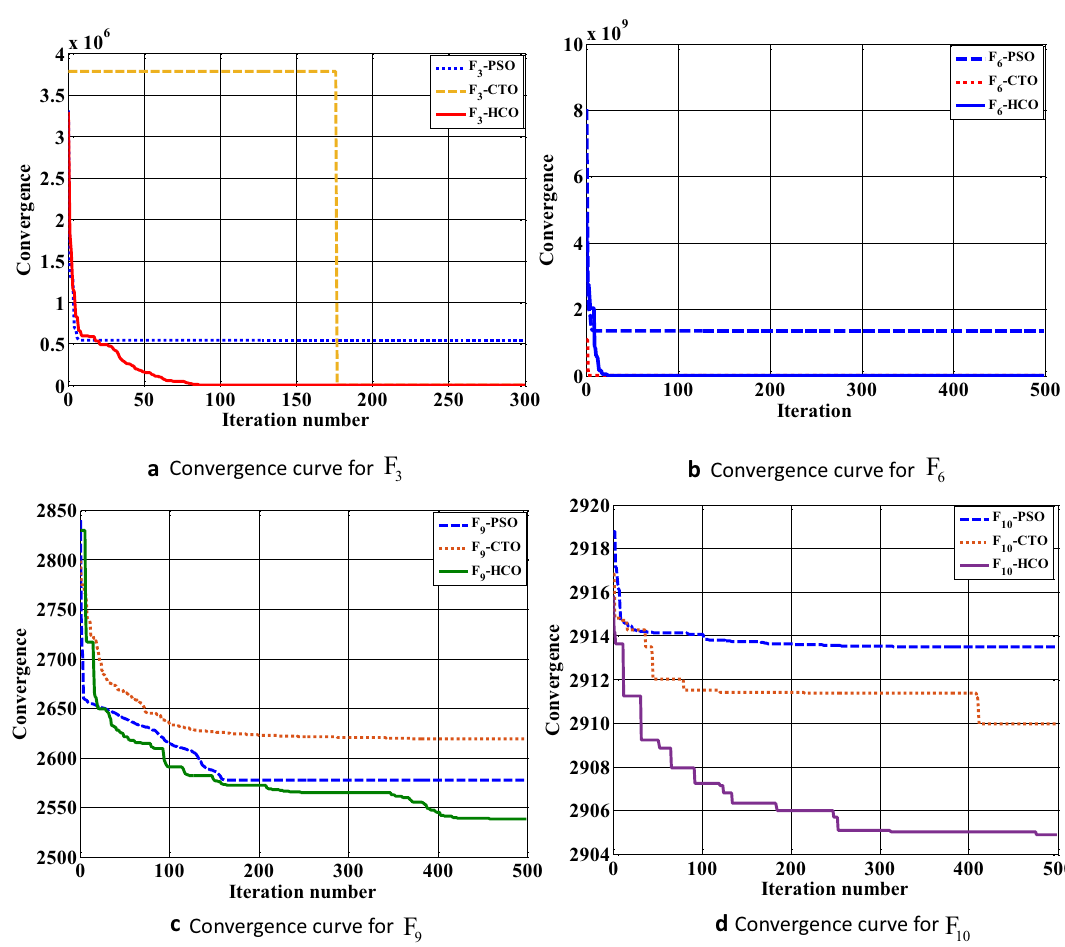
F Convergence curve for Convergence curve for 10